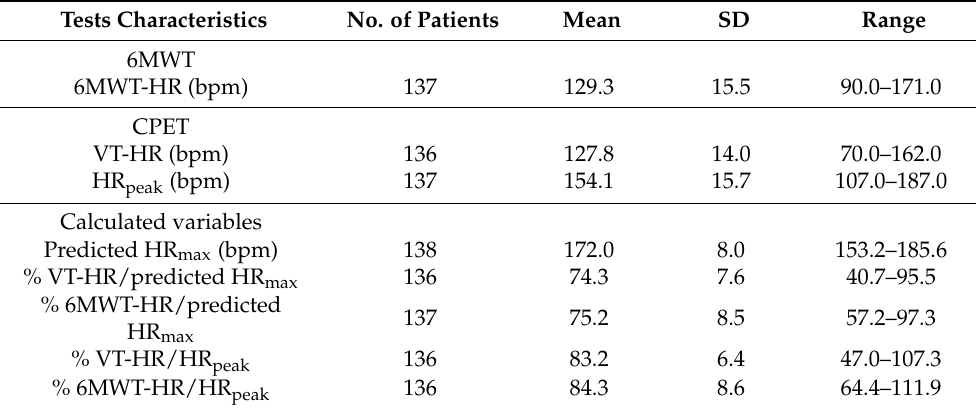
Table 2. The HRs of the CPET and 6MWT at baseline ( N = 138).